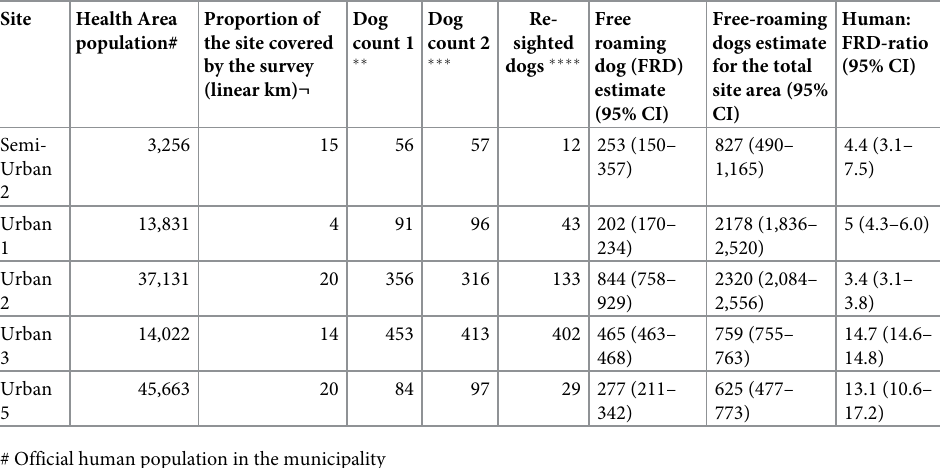
Table 3. Sight–Re Sight survey sites. Guatemala March–July 2018.